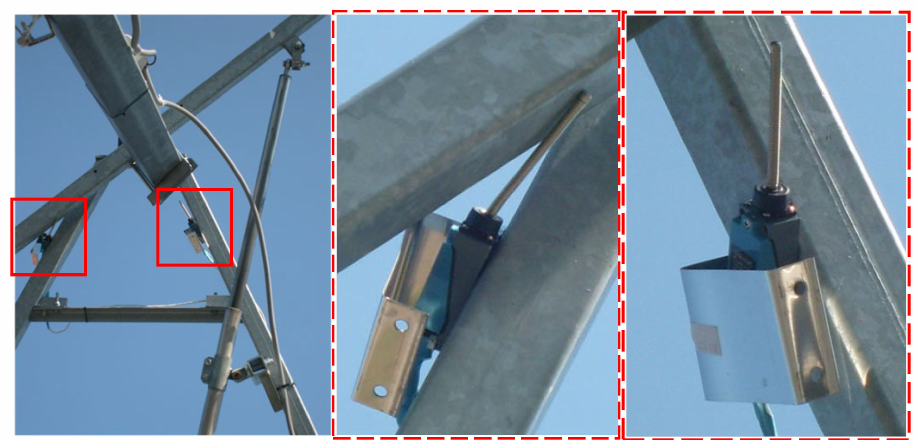
Figure 7. Location of end sensors of the